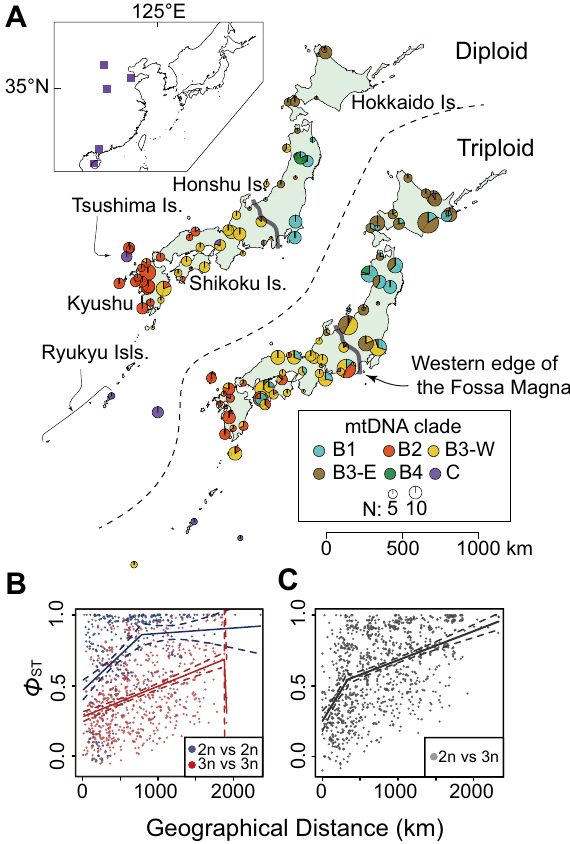
Figure 3. Population structure of Carassius , showing weaker geographical population structure of gynogenetic triploids than that of sexual conspecific diploids. ( A ) Geographic distribution of mitochondrial lineages of diploid and triploid Carassius in Japan. ( B , C ) Isolation by distance (IBD) in Carassius fish based on mtDNA haplotypes from 54 river systems in Japan. ( B ) IBD among diploids (blue) and triploids (red). ( C ) IBD between diploids and triploids. The maps were generated using the R package mapdata.